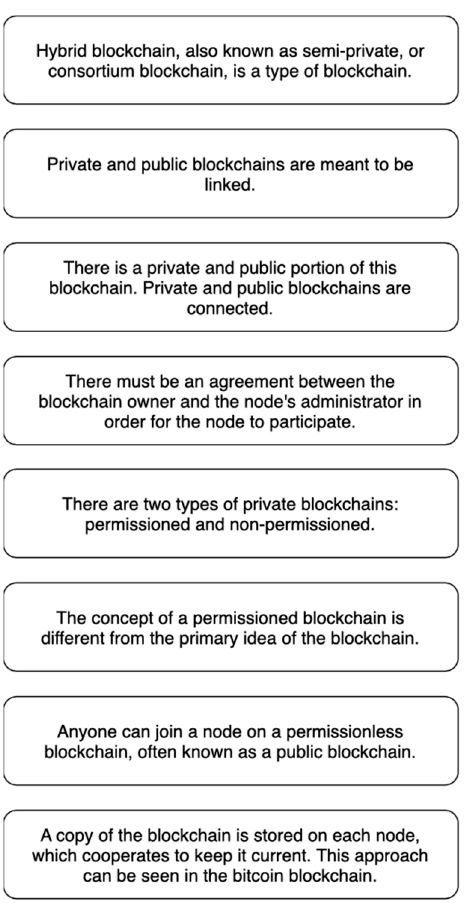
Figure 7. Blockchain Ownership.